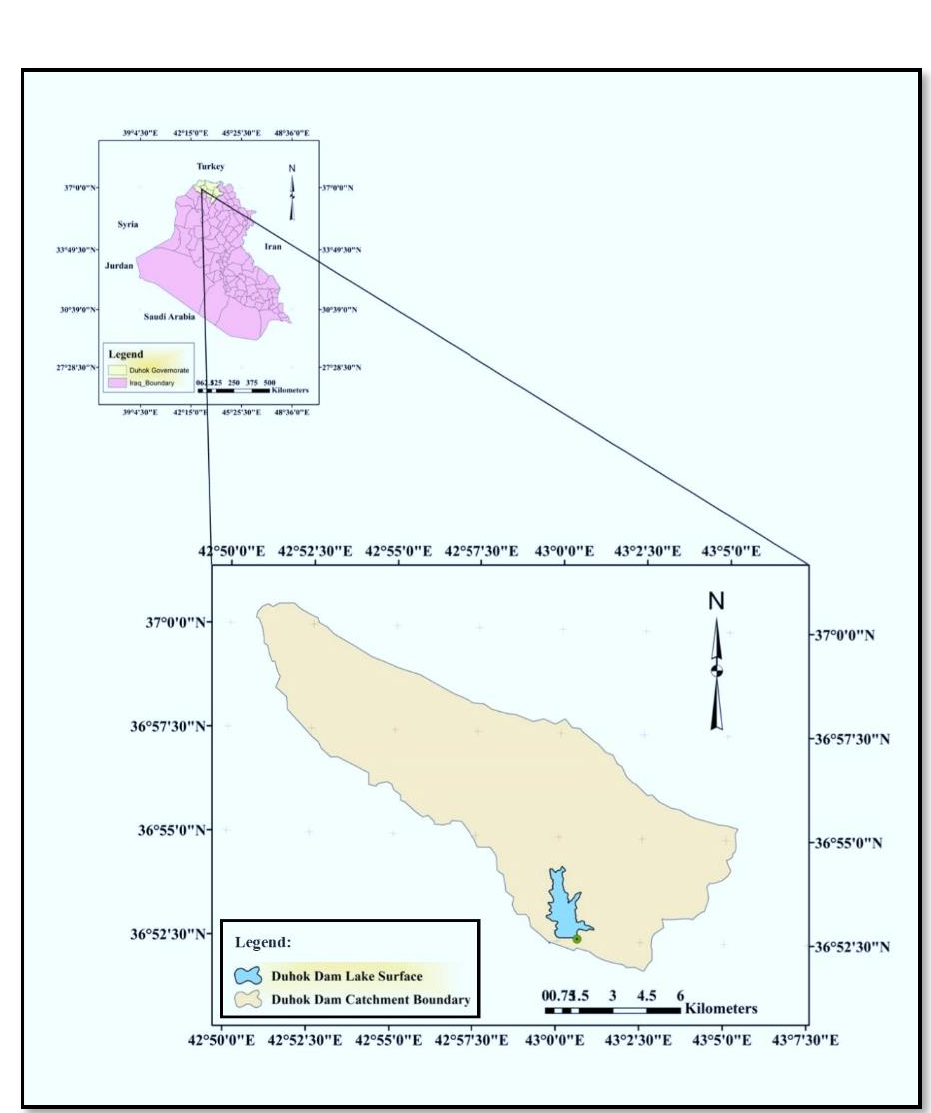
Figure 1. Duhok Dam Basin and its